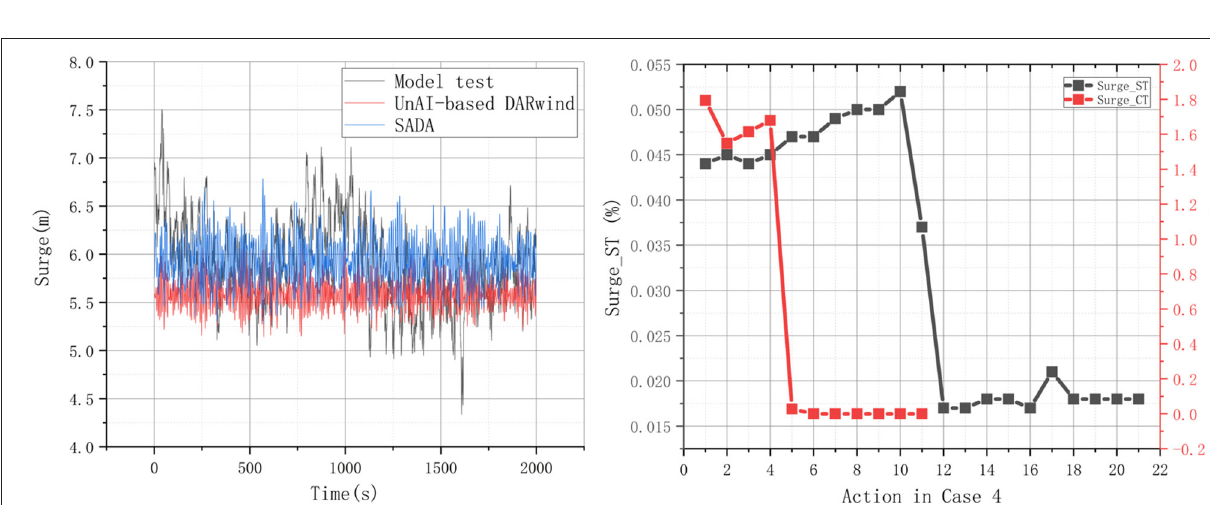
FIGURE 9 | Comparison of surge motion in case